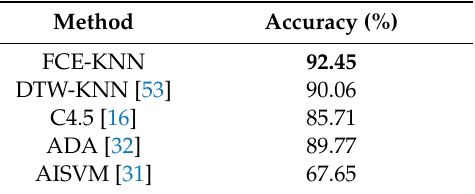
Table 4. Accuracy comparison between FCE-KNN and other algorithms for identifying application type of encrypted network flows.